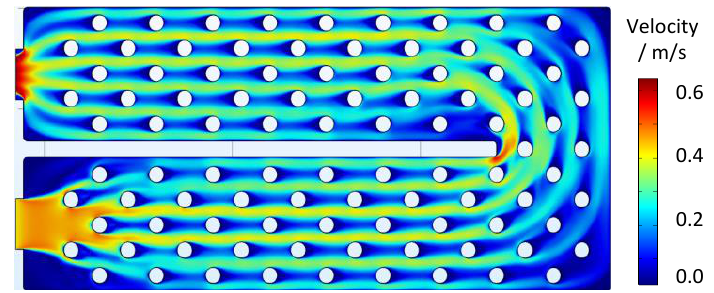
Figure A3. Velocity profile of the coolant plate for a mass flow of 0.05 kg/s.